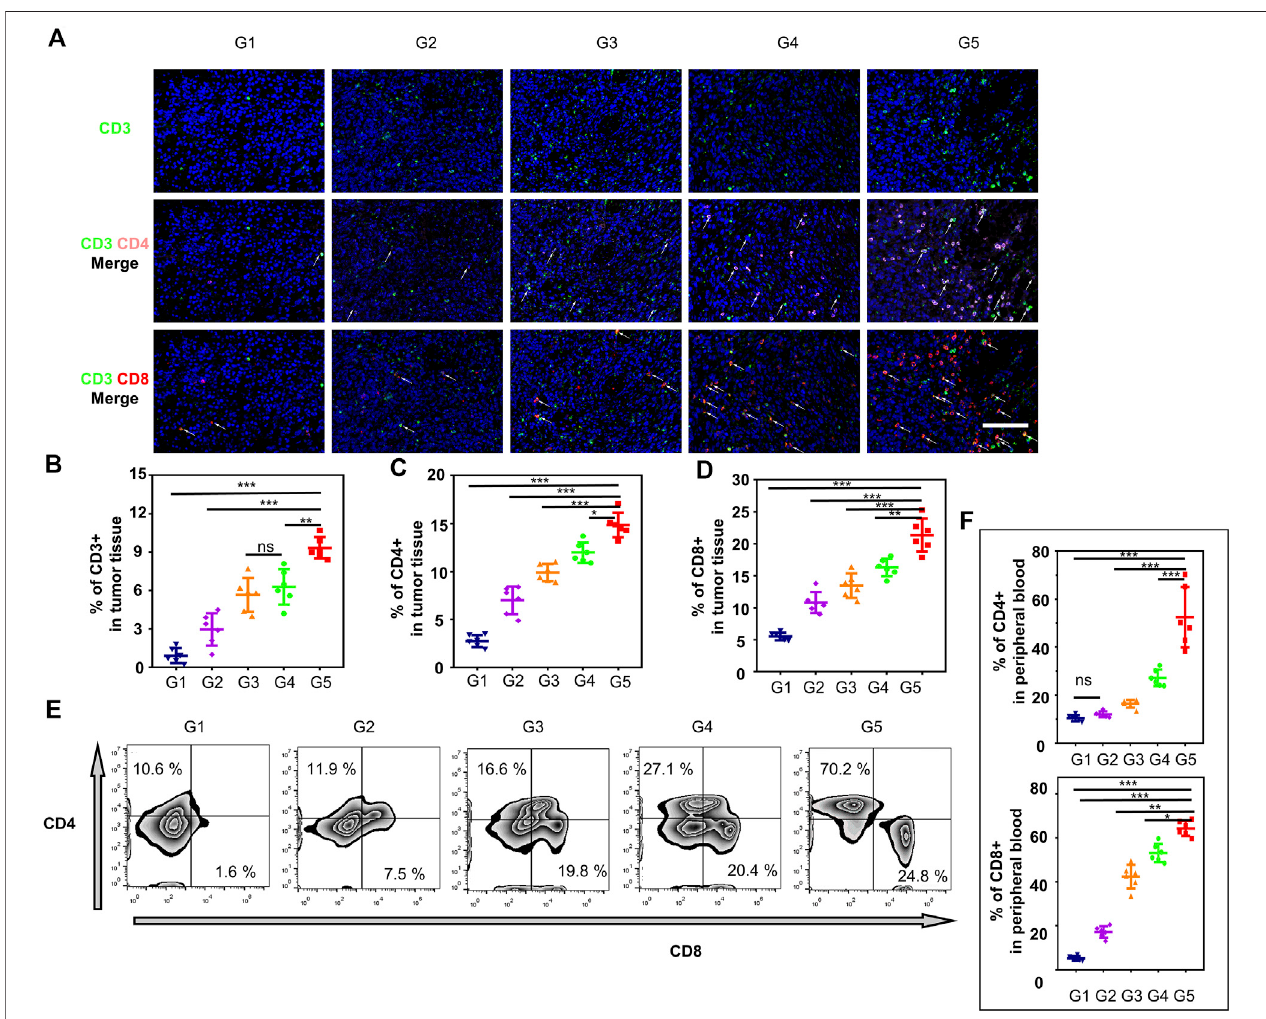
FIGURE9| Theimmuneeffectsfromdifferenttreatmentgroupswereevaluated in-vivo . (A) Representativeimmuno fl uorescenceimagesshowingtumor-in fi ltrating CD3 + CD4 + and CD3 + CD8+T cells within 4T1 tumors for different treatment groups (G1 – G5). (B – D) percentages of CD3 + , CD4 + , or CD8 + T cells obtained from tumor tissues (A) . (E) Representative fl ow cytometry plots of CTLs (CD4 + CD8 + ) gated on CD3 + CTLs in peripheral blood, respectively. (F) Quanti fi cation (%) of CD4 + CD8 + gated on CD3 + CTLs. All data are presented as mean ± SD ( n (cid:2) 6, ns, not signi fi cant; * p < 0.05, ** p < 0.01, *** p <